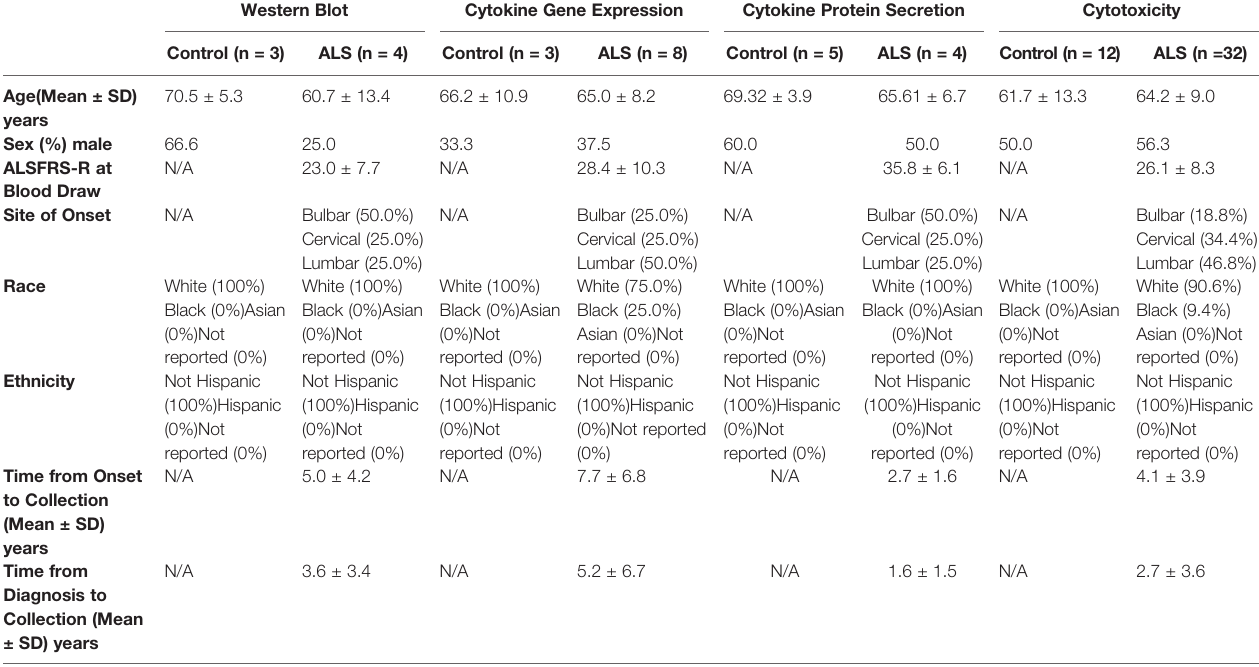
TABLE 1 | Subject demographics for primary NK cell